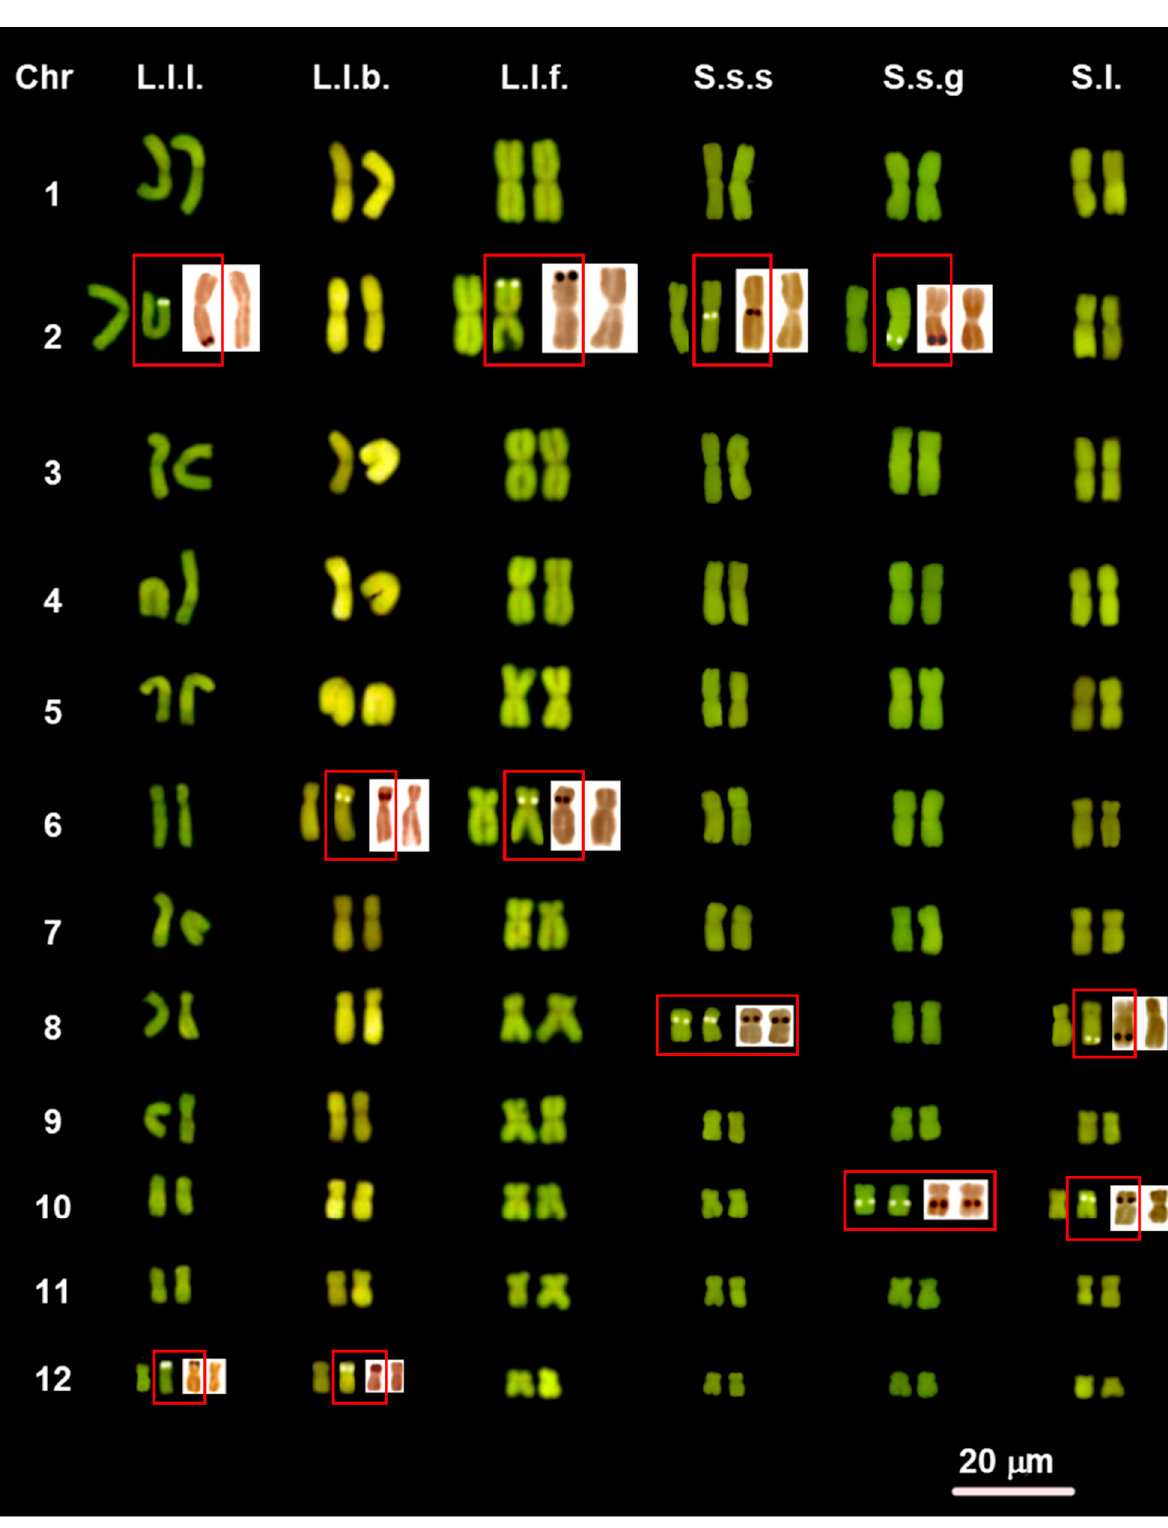
Figure 2. CMA 3 -stained karyotypes of: L.l.l = L. l. luschani ; L.l.b. = L. l. basoglui ; L.l.f. = L. l. finikensis ; S.s.s. = S. s. salamandra ; S.s.g. = S. s. gigliolii ; S.l. = S. lanzai . NOR-bearing chromosomes stained with CMA 3 ( left ) and Ag-NOR staining ( right ). The red boxes highlight the occurrence of homomorphic and/or heteromorphic loci.